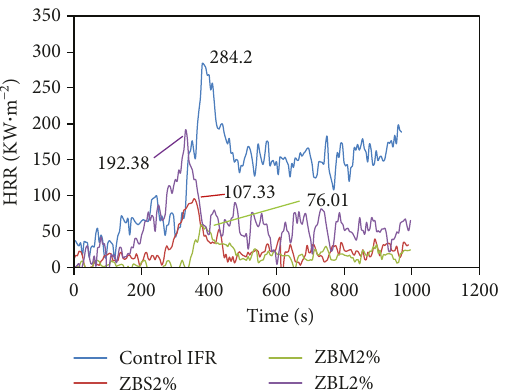
Figure 9: Heat release rate of wood treated with IFR/ZB coatings (50 kw · m -2 ).